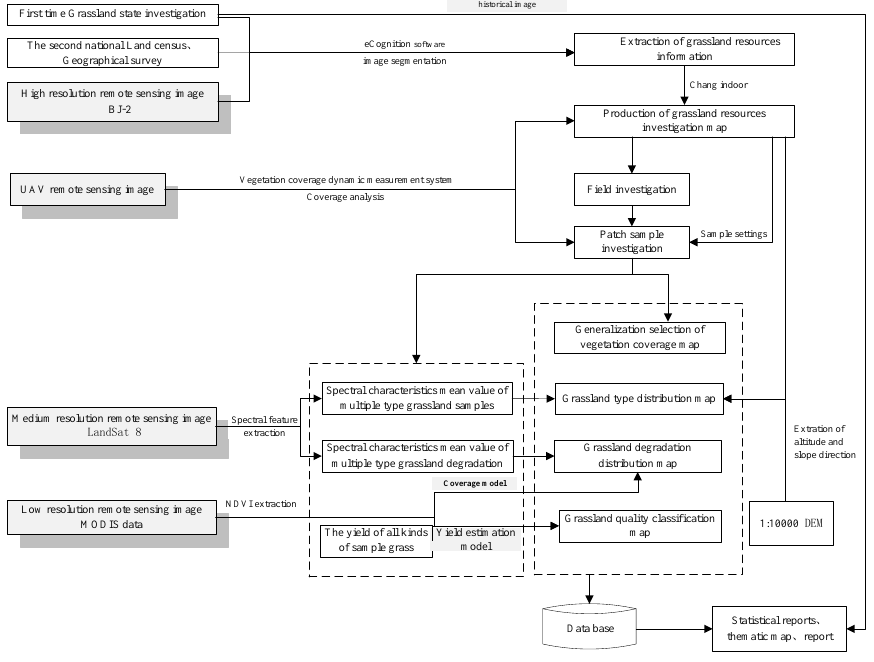
Figure 1. Grassland resources remote sensing image application flow